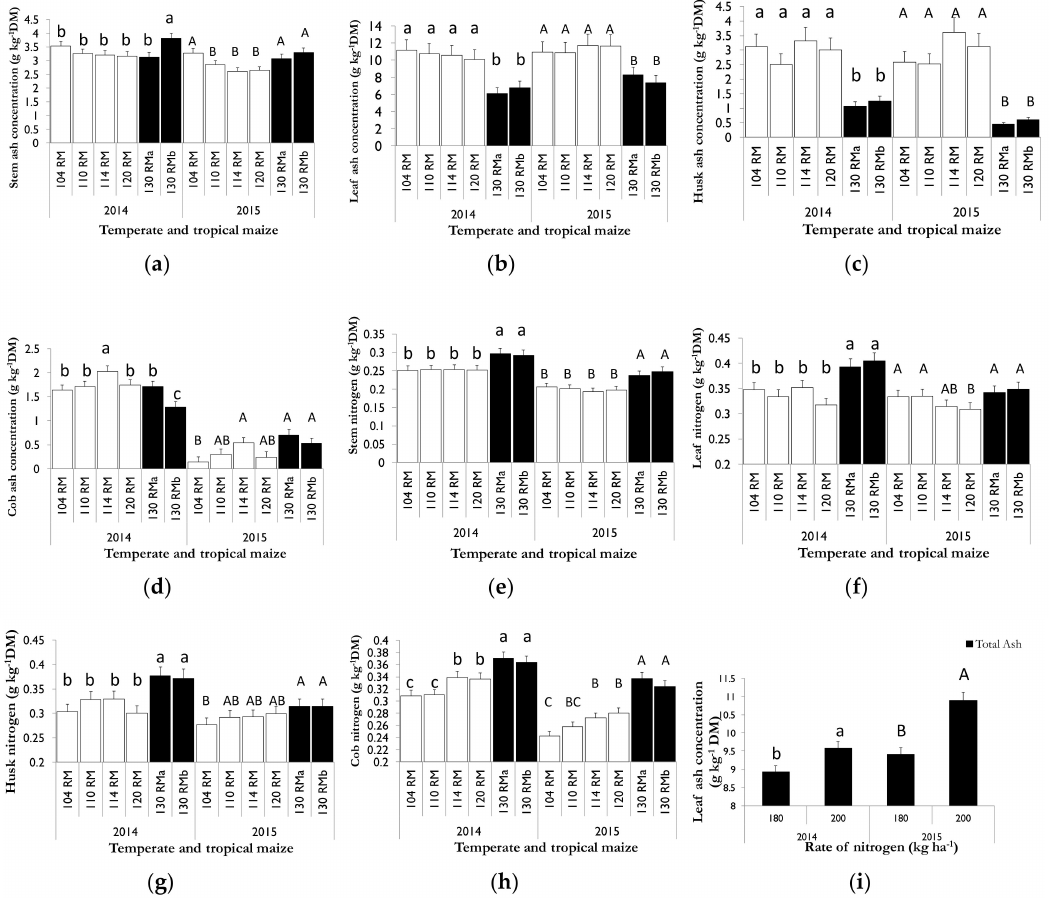
Figure 5. ( a – i ). Differences in ( a – d ) total ash, and ( e – h ) nitrogen concentrations among temperate and tropical maize by stems, leaves, husks, and cobs during 2014 and 2015 in Boone County, IA. ( i ) Effect of nitrogen rate on leaf ash concentration (g kg − 1 ) during two growing seasons averaged over temperate and tropical maize grown in Boone County, IA. Treatments were determined within each year. RM stands for relative maturity type, and two different RM ( a , b ) are presented when corn of relative maturity of 130 is evaluated. Different letters on the top of standard error bars mean significant differences among treatments ( p >